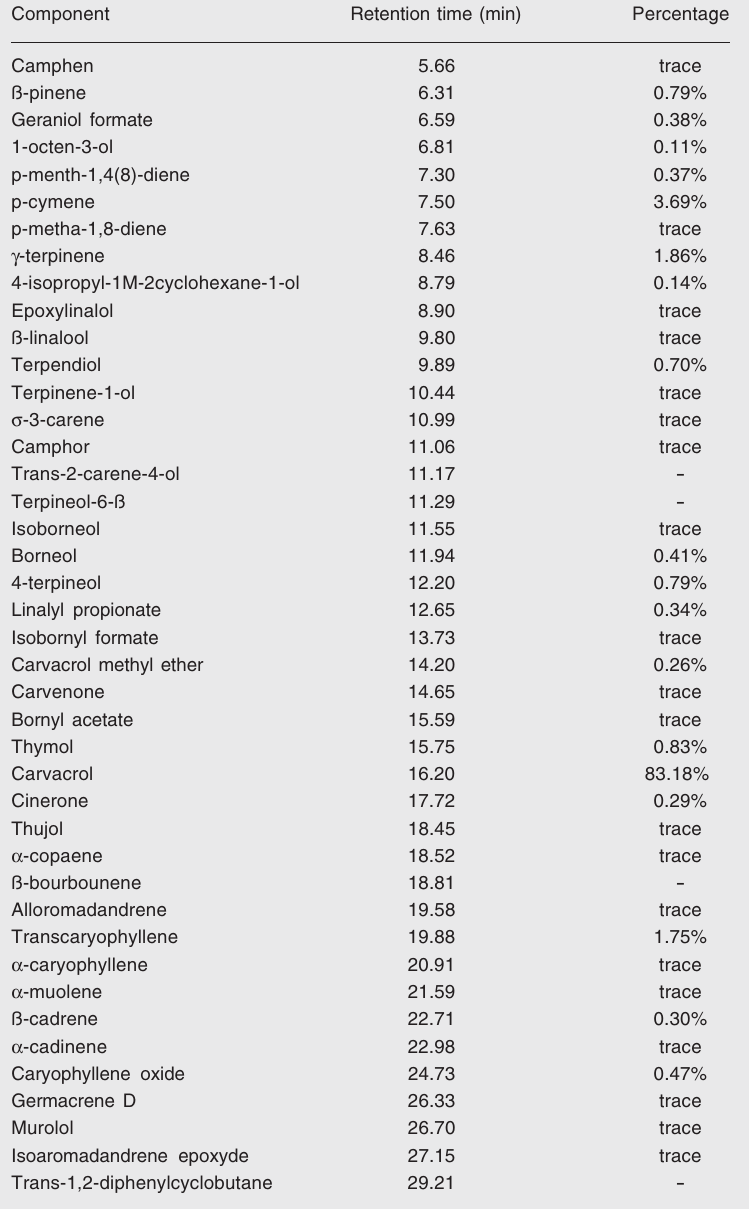
Table 1. Composition of the essential oil of Thymus broussonettii and gas chromatog- raphy retention times .